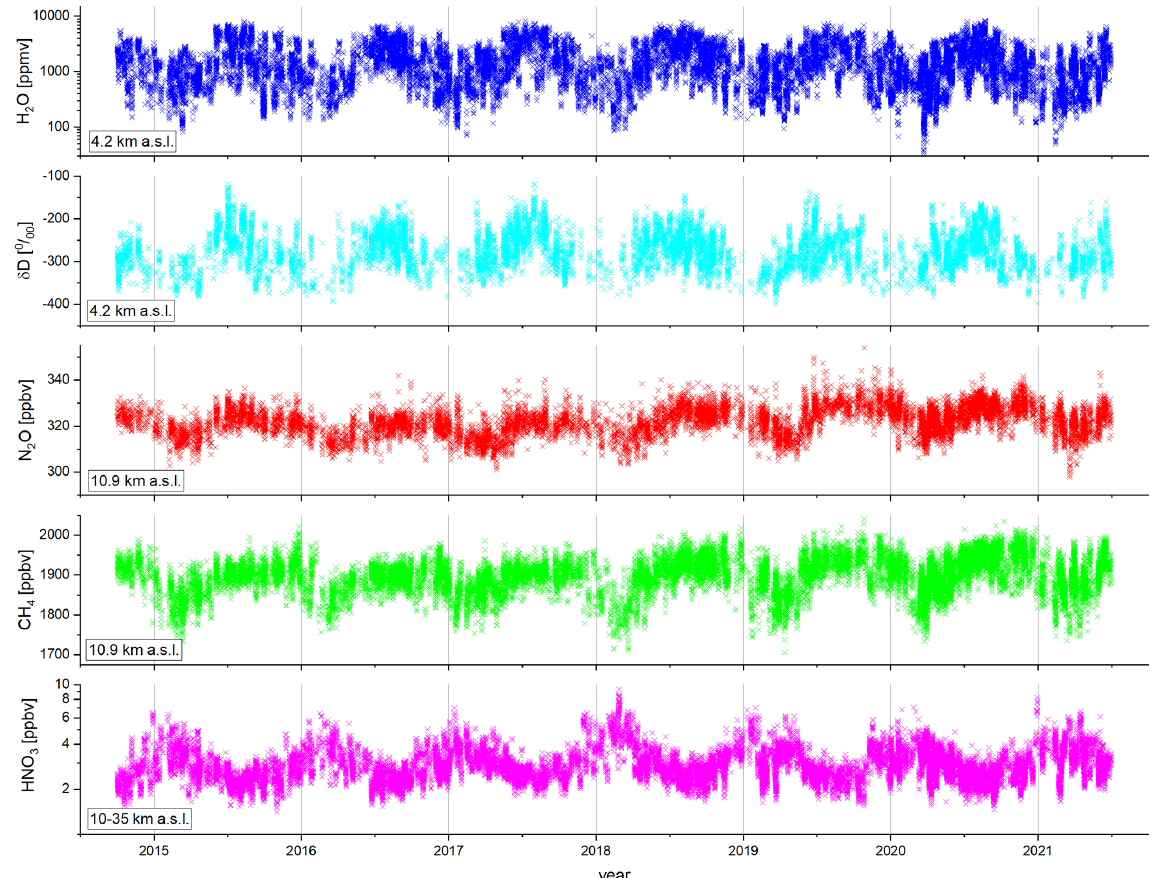
Figure 14. Time series of MUSICA IASI trace gas products at selected altitudes above Karlsruhe (48–49 ◦ N, 8–9 ◦ E): 4.2kma.s.l. for H 2 O and δ D, 10.9kma.s.l. for N 2 O and CH 4 , and 10–35kma.s.l. for HNO 3 . Data have been filtered according to the settings given in Table 4.